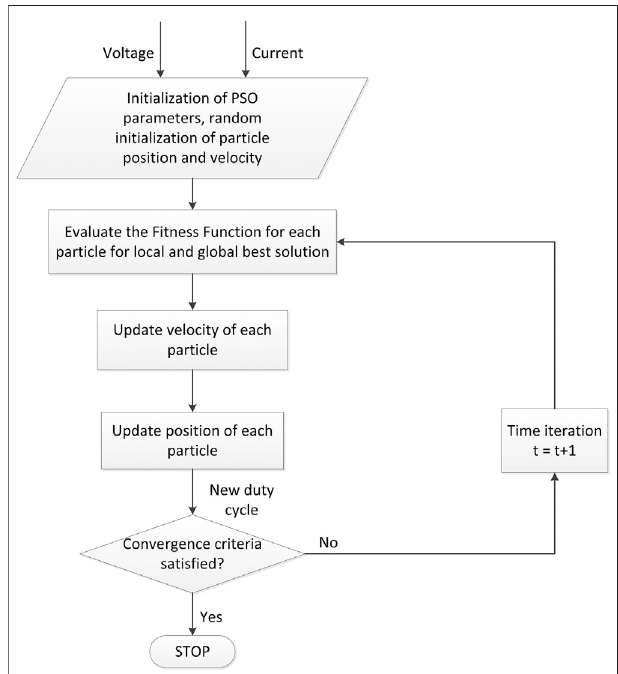
FIGURE 1 | Flowchart of conventional